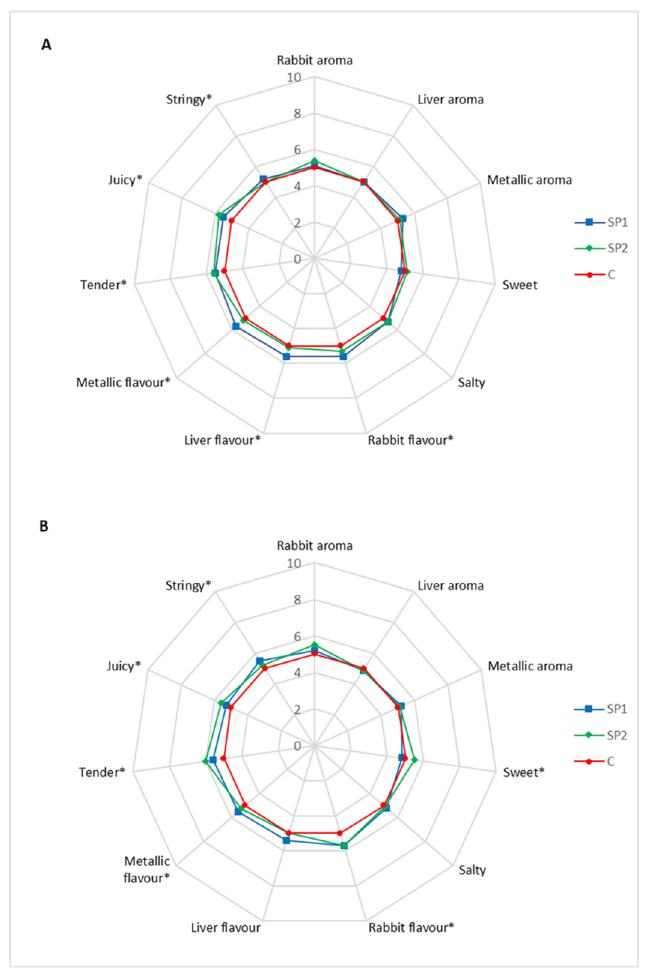
Figure 2. Spider plot of the sensory profile of Longissimus lumborum muscle ( A ) and thigh ( B ) of rabbit fed the control diet (C) and the diet supplemented with 3 g / kg (SP1) and 6 g / kg (SP2) of brown seaweed and plant polyphenols. * Significant at p < 0.05.